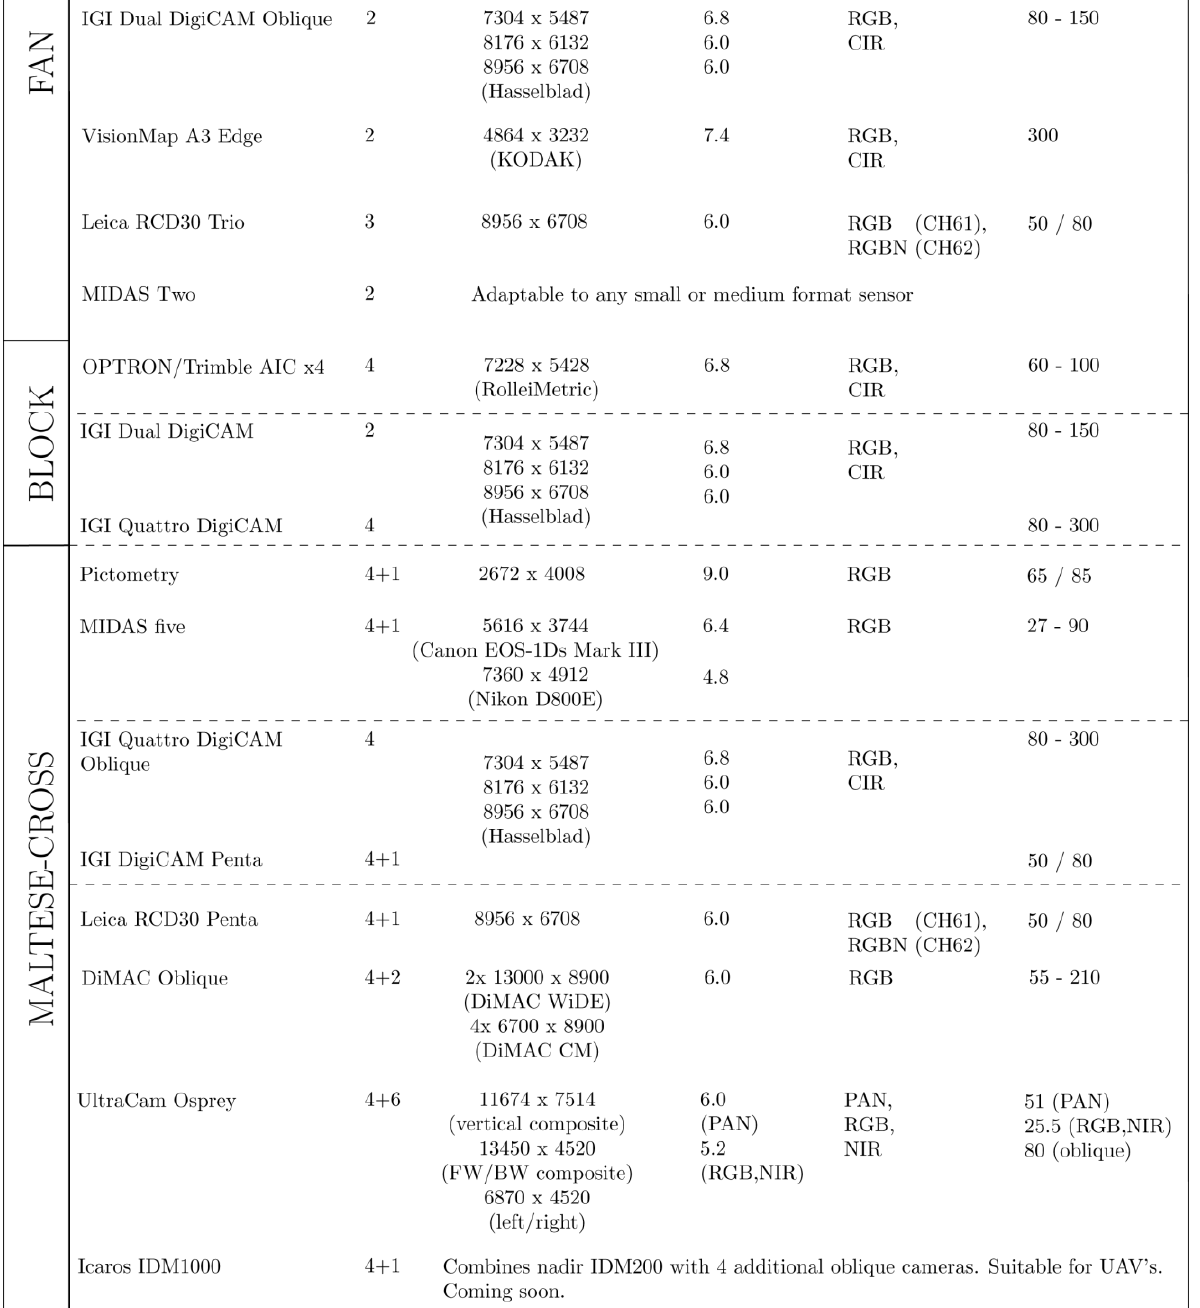
Table 1: Primary commercial oblique multi-camera airborne systems (after Petrie, 2009a). ”Maltese-cross” configuration: it consists of a single nadir tendencies within the configuration: one is present among camera and four cameras tilted towards cardinal directions by small- and medium-format size and it stresses the modularity 40 - 50°. This configuration is the most common and also the concept and flexibility (IGI, Midas TRACK’AIR, Leica), the most diverse. It contains small-, medium- and large-format other produces ’closed’ systems and invests into larger, often frame cameras. There are two observable development more powerful, sensor chips (Microsoft, CICADE,